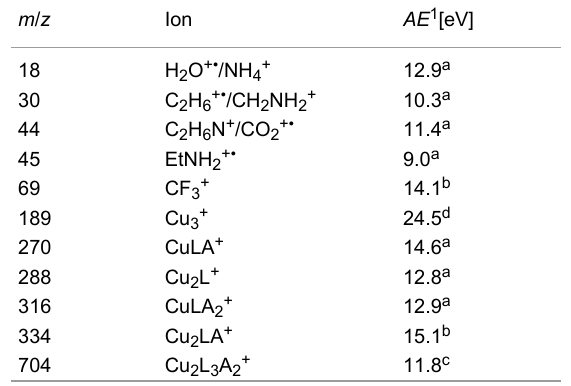
Table 2: Appearance energies for selected ions from dissociation of [Cu 2 (EtNH 2 ) 2 (µ-O 2 CC 2 F 5 ) 4 ] induced by electron impact ionization.